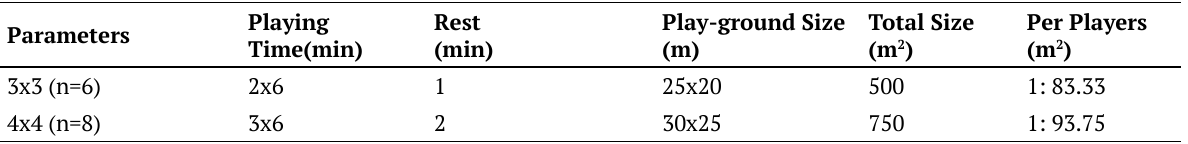
Table 2. Dimension of Small-Sided